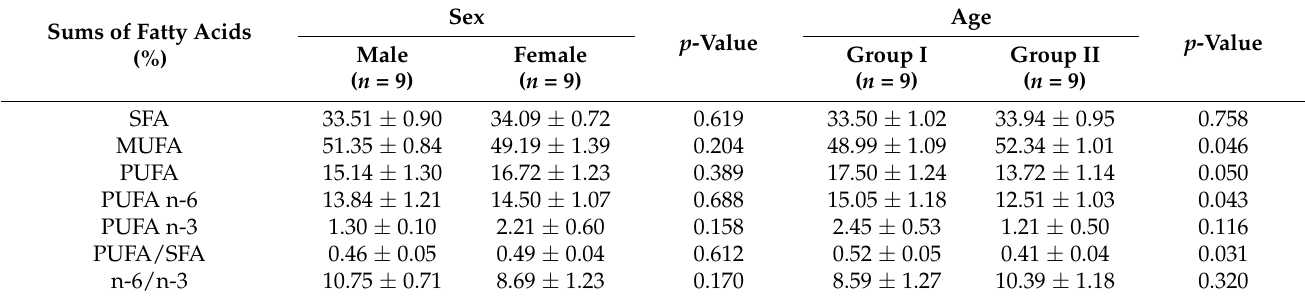
Table 3. Fatty acid sums in the brown bear, M. semimembranosus , as influenced by sex and age groups (mean ± SE). Sums of Fatty Acids